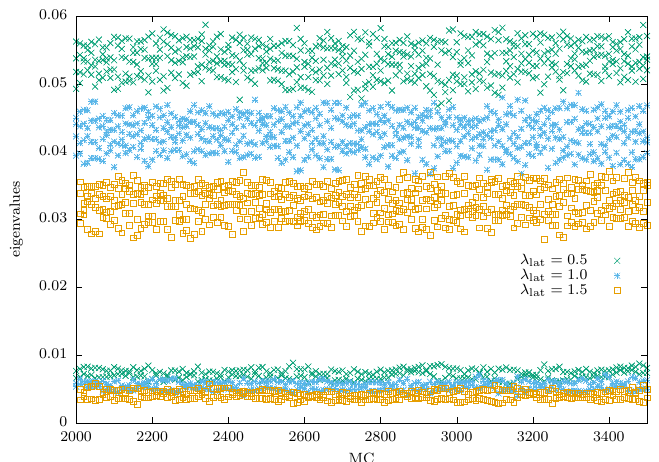
Figure 4. Monte Carlo history of the 2 × 6 lowest D † D eigenvalue pairs for gauge group U(2) on 12 4 lattices with different values of the ’t Hooft coupling λ lat . The eigenvalues are measured on thermalized configurations separated by 10 ‘MC’ units on the horizontal axis.